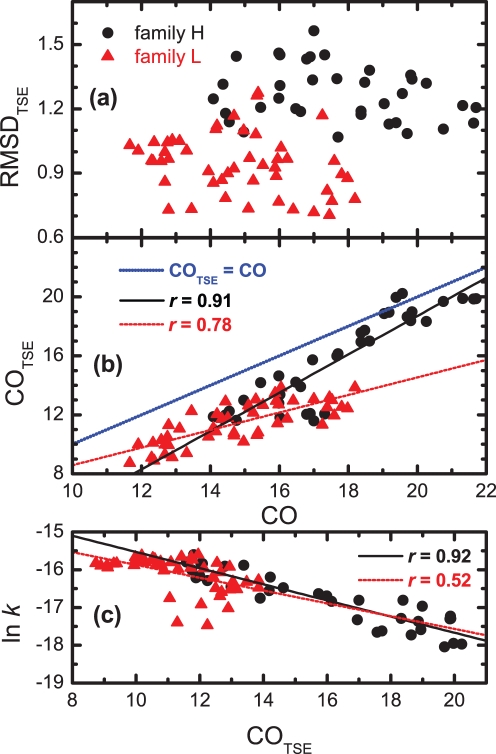
Structural variability in the TSE measured by (a) the RMSD to the native structure (in lattice units) and (b) the relation between the contact order of the TSE and the native contact order.In both families, COTSE is typically smaller than the CO, a trend that is also observed in real-world proteins [42]. In family H there is a strong correlation between the COTSE and the CO, despite the considerably large structural variability. In family L, on the other hand, the COTSE is significantly less correlated with that of the native structure, and in this case the RMSDTSE is significantly lower. (c) Dependence of ln k on the average contact order of the transition state ensemble.